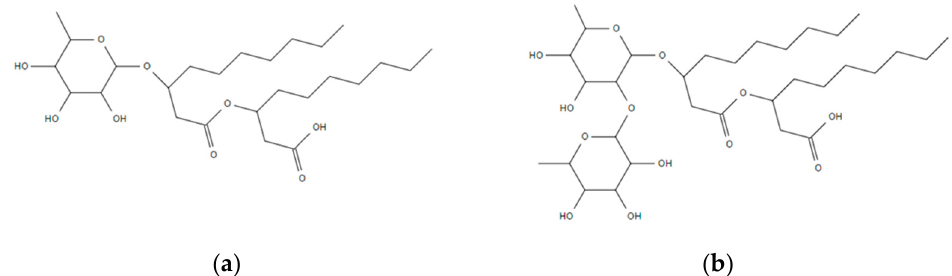
Figure 1. Chemical structures of ( a ) mono-rhamnolipid and ( b ) di-rhamnolipid.